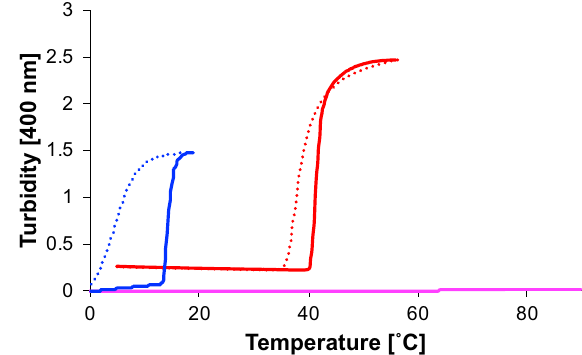
Figure 8. Turbidity profiles of AADAAC-(FPGV) 4 . Turbidity changes of AADAAC-(FPGV) 4 in Tris–HCl buffer solution (50.0 mM Tris, pH 8.4) associated with heating (solid lines) and cooling (dashed lines). Red lines: 10 mg/mL (4.71 mM) of AADAAC-(FPGV) 4 ; magenta lines: 0.5 mg/mL (0.236 mM) of AADAAC-(FPGV) 4 in the presence of 154 mmol NaCl; blue lines: 0.5 mg/mL (0.236 mM) of AADAAC-(FPGV) 4 in the presence of 154 mmol NaCl and 0.236 mM CdCl 2 .